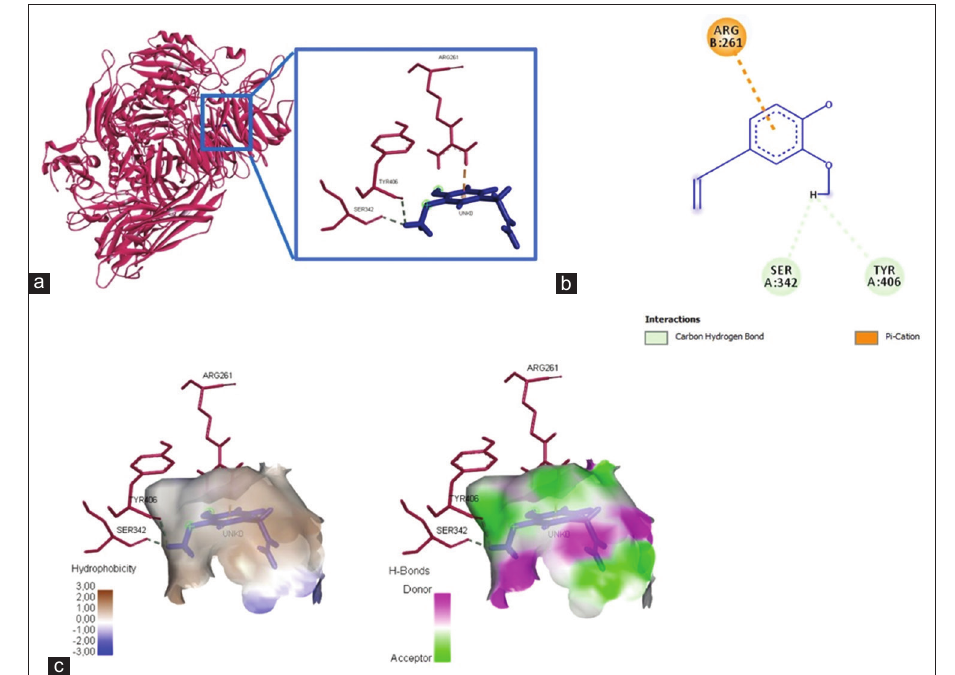
Figure-6: The visualization of the three-dimensional and two-dimensional interaction between phenolic compounds (eugenol) and integrin α v β 3. (a) Three-dimensional structural interaction between phenol-ligand eugenol compounds (blue) and integrin α v β 3 (red). (b) This interaction is established by hydrophobic hydrogen bonds (green) and aromatic bonds (yellow) on the active site of the vb3 integrin, namely, Ser342, Tyr406, and Arg261, which can be seen in the two- dimensional (b) and three-dimensional (c) structures.